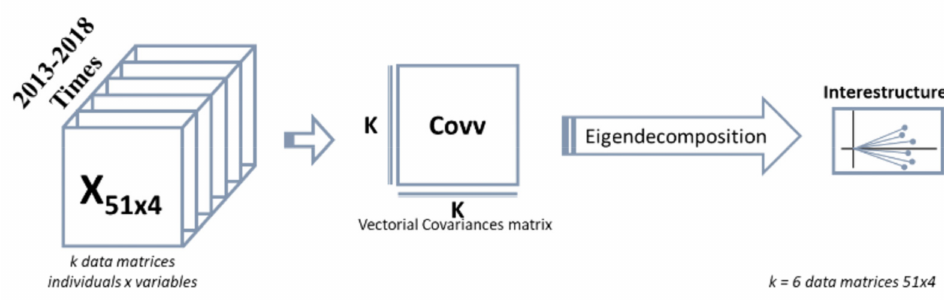
Figure 1. Interstructure analysis flow chart in X-STATIS.